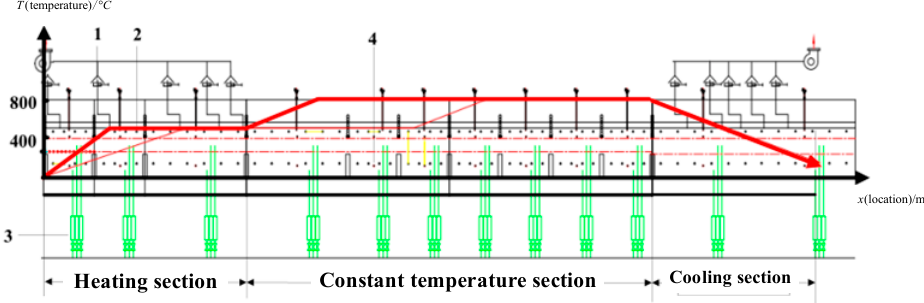
Figure 2. Variation trend of the internal temperature of a roller kiln.